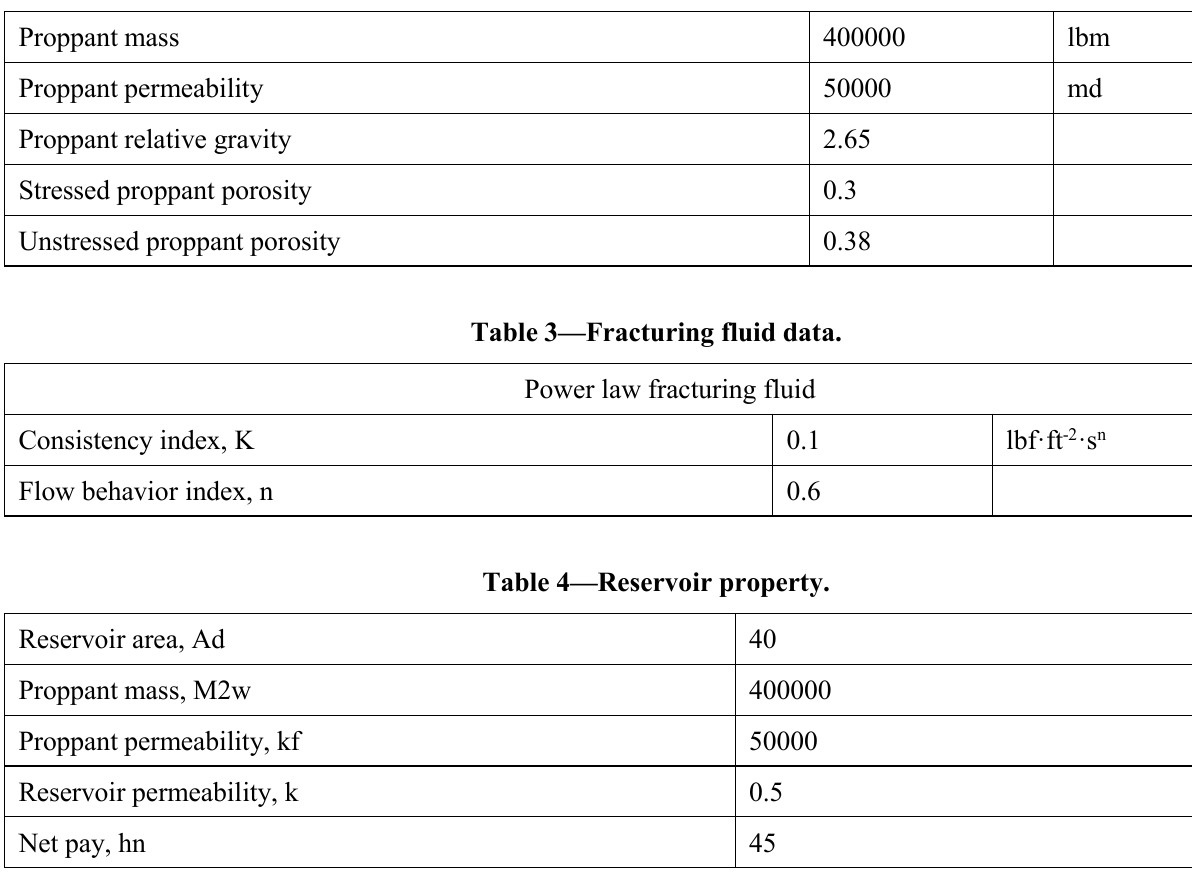
Table 2—Proppant data.